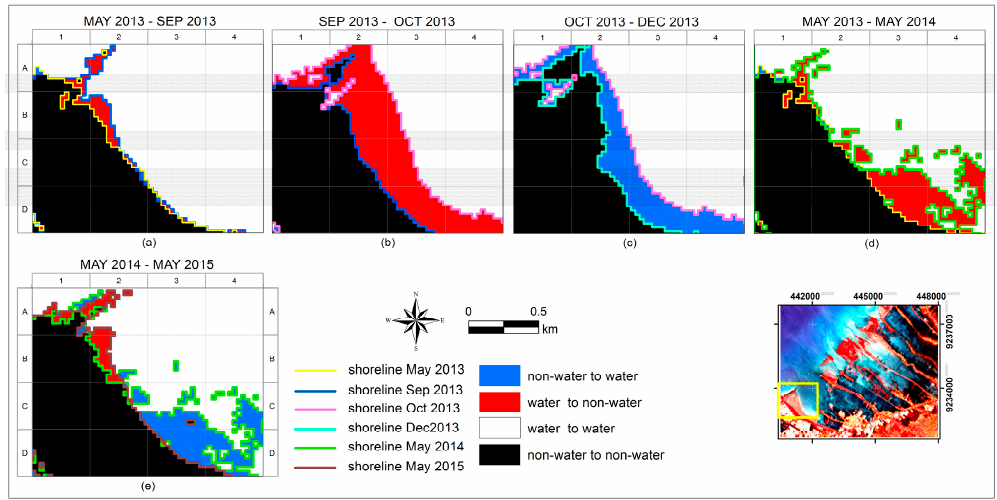
Figure 9. Change detection of shorelines using post classification comparison of MLC results; ( a – c ) the change of shorelines in three consecutive dates in 2013; ( d ) shoreline changes from 2013 to 2014; and ( e ) shoreline changes from 2014 to 2015. Blue polygons show the changes of non-water to water and red polygons display the changes from water to non-water . No-change areas of water and non-water are represented by white and black polygons, respectively.